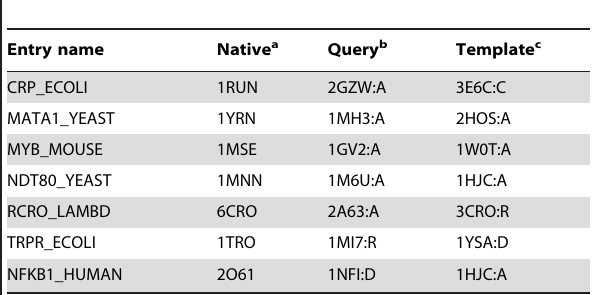
Table 2. The PDB entries used in this